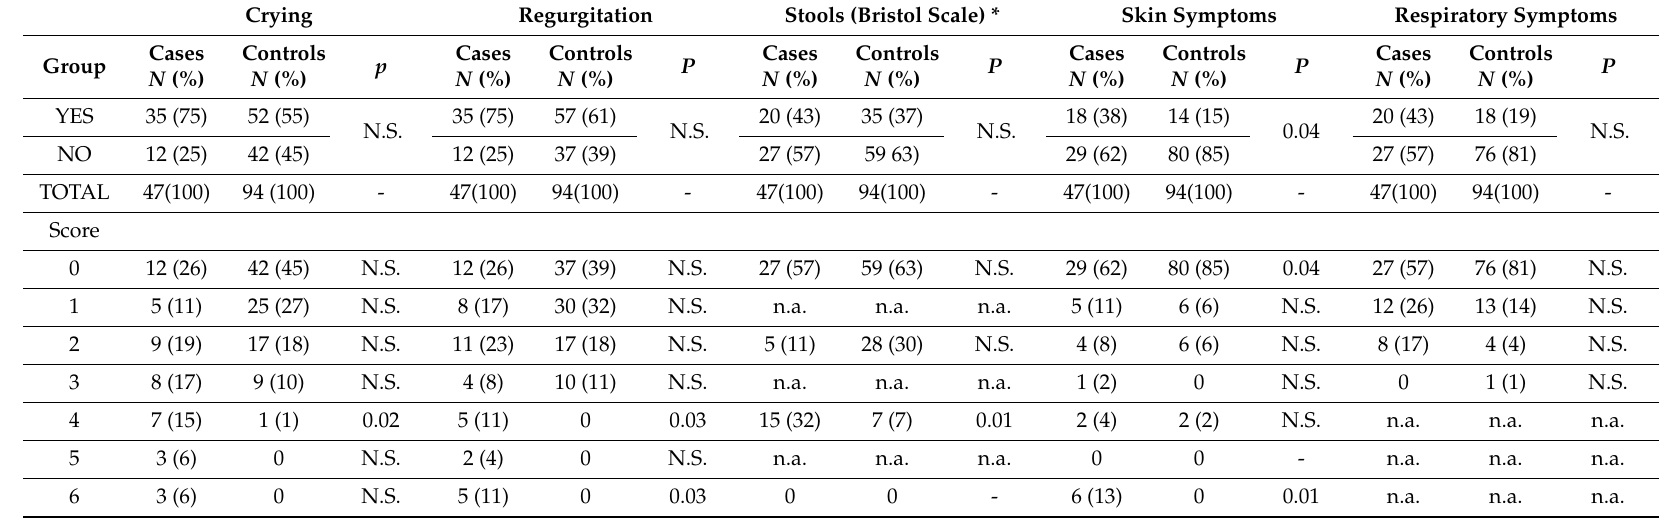
Table 1. Comparison of CoMiSS TM items and scores between cases and